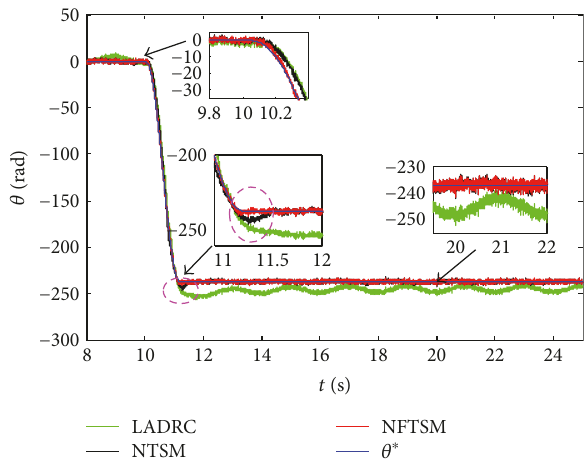
Figure 11: Angular position tracking results by di ff erent